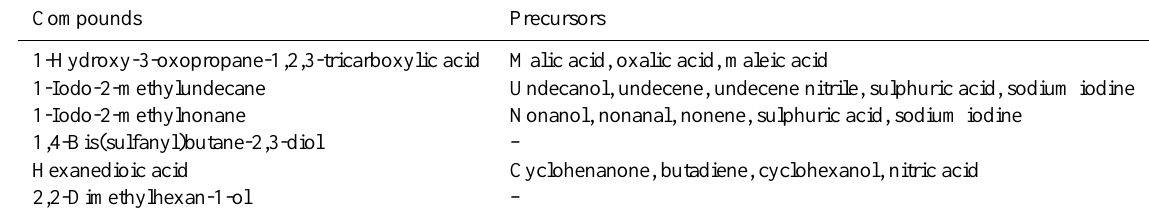
Table 5. Potential identified precursors in water and aerosol phases for the compounds in groups 1 and 2.